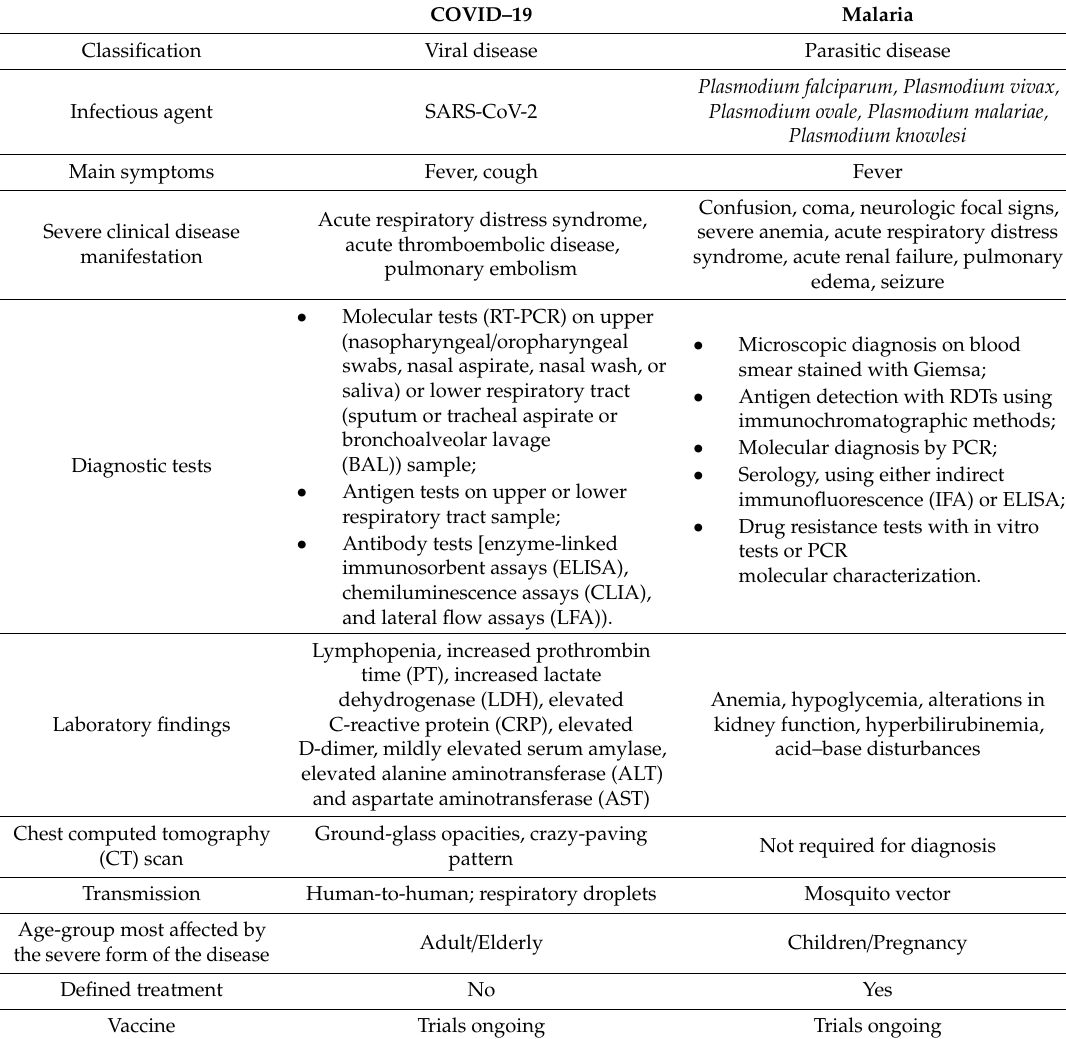
Table 1. Summary of the principal characteristics of COVID-19 and